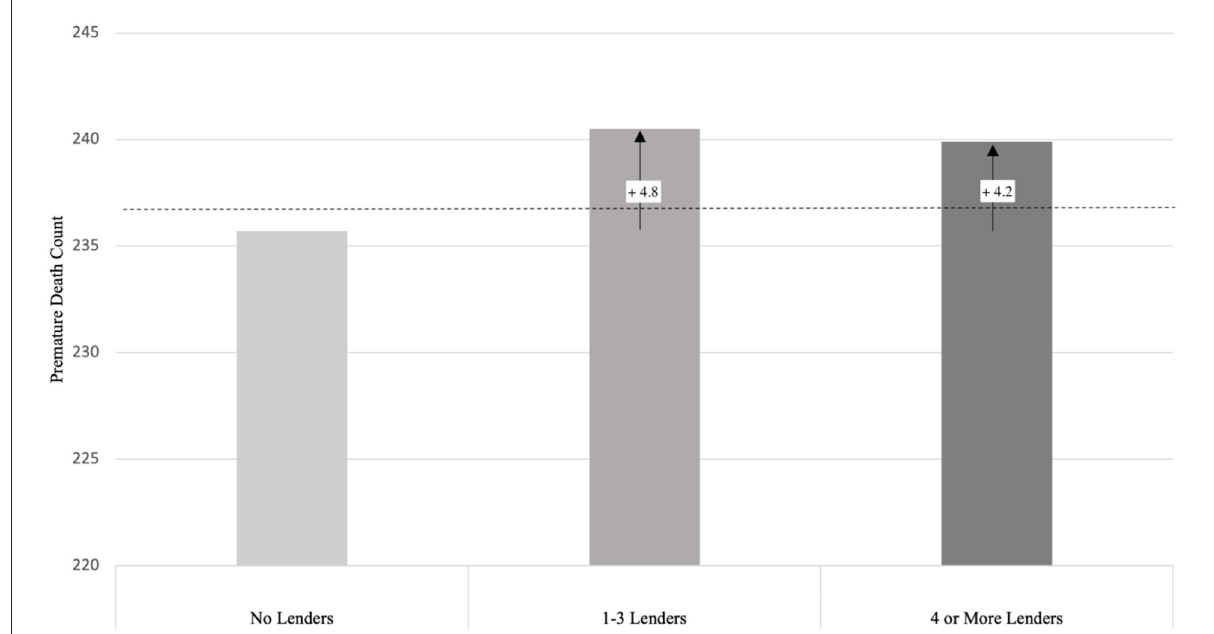
FIGURE2 Predicted excess premature deaths in counties with lenders. The higher adjusted incidence risk ratios ( p < 0.05) in M3 of Table 2 for counties with 1 to 3 and 4 or more lenders translate to 4.8 and 4.2 excess deaths, respectively, compared to counties with no lenders. Estimated death counts are derived from Model 3 in Appendix B using Stata margins and lincom commands. Dashed line represents overall grand mean (238.4 deaths), derived from same model. 2,626 counties contributed 42,230 observations.